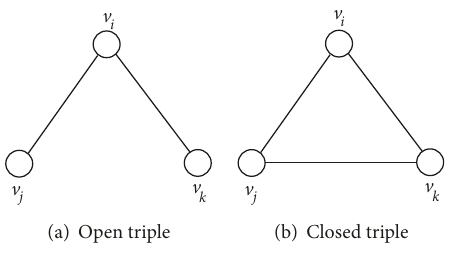
Figure 1: Open triple and closed